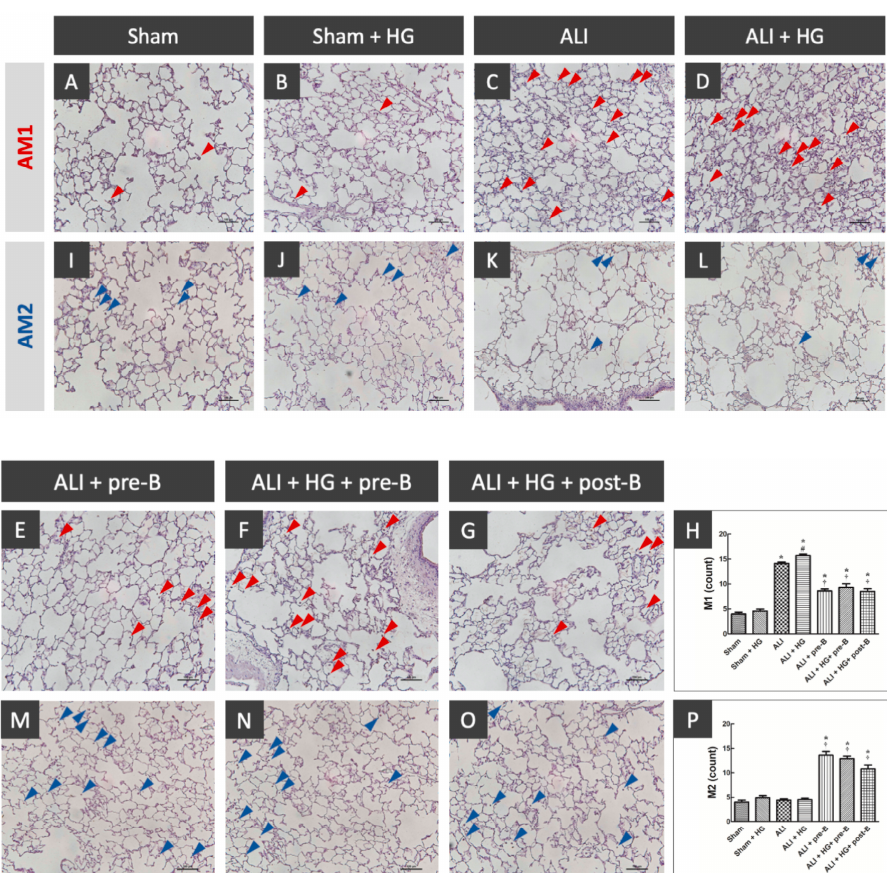
Figure 5. Effects of hyperglycemia and NKCC1 inhibitor treatment on macrophages. The sections collected from rats of the sham ( A ) and sham + HG ( B ) groups showed rare distribution of AM1 (red arrow). Higher AM1 infiltration was noted in the rats of the ALI ( C ) and ALI + HG ( D ) groups. Decreased AM1 infiltration was noted in rats of the ALI-pre-B ( E ), ALI + HG + pre-B ( F ) and ALI + HG + post-B groups ( G ). The AM1 counts ( H ) were higher in rats with ALI and further increased in the ALI + HG group ( p < 0.05). The NKCC1 inhibitor reduced AM1 counts in both ALI and ALI + HG groups ( p < 0.05). The AM2 infiltration (blue arrow) was rare in the sham ( I ), sham + HG ( J ), ALI ( K ) and ALI + HG ( L ) groups. Increased AM2 infiltration was noted in rats of the ALI + pre-B ( M ), ALI + HG + pre-B ( N ) and ALI + HG + post-B groups ( O ). The AM2 counts ( P ) were low in rats of sham, sham + HG, ALI and ALI + HG. The NKCC1 inhibitor increased AM2 counts in both ALI and ALI + HG groups ( p < 0.05). *Significant difference, as compared to the sham group ( p < 0.05), # Significant difference, comparing the groups with HG to those without HG (I vs. II, III vs. IV, V vs. VI, and V vs. VII, p < 0.05), † Significant difference, comparing the ALI groups with B to those without B (III vs. V, IV vs. VI, and IV vs. VII, p < 0.05). Abbreviation: AM1 = alveolar macrophage 1, AM2 = alveolar macrophage 2, ALI = acute lung injury, HG = hyperglycemia, pre-B = pretreatment with bumetanide, post-B = post-treatment with bumetanide.